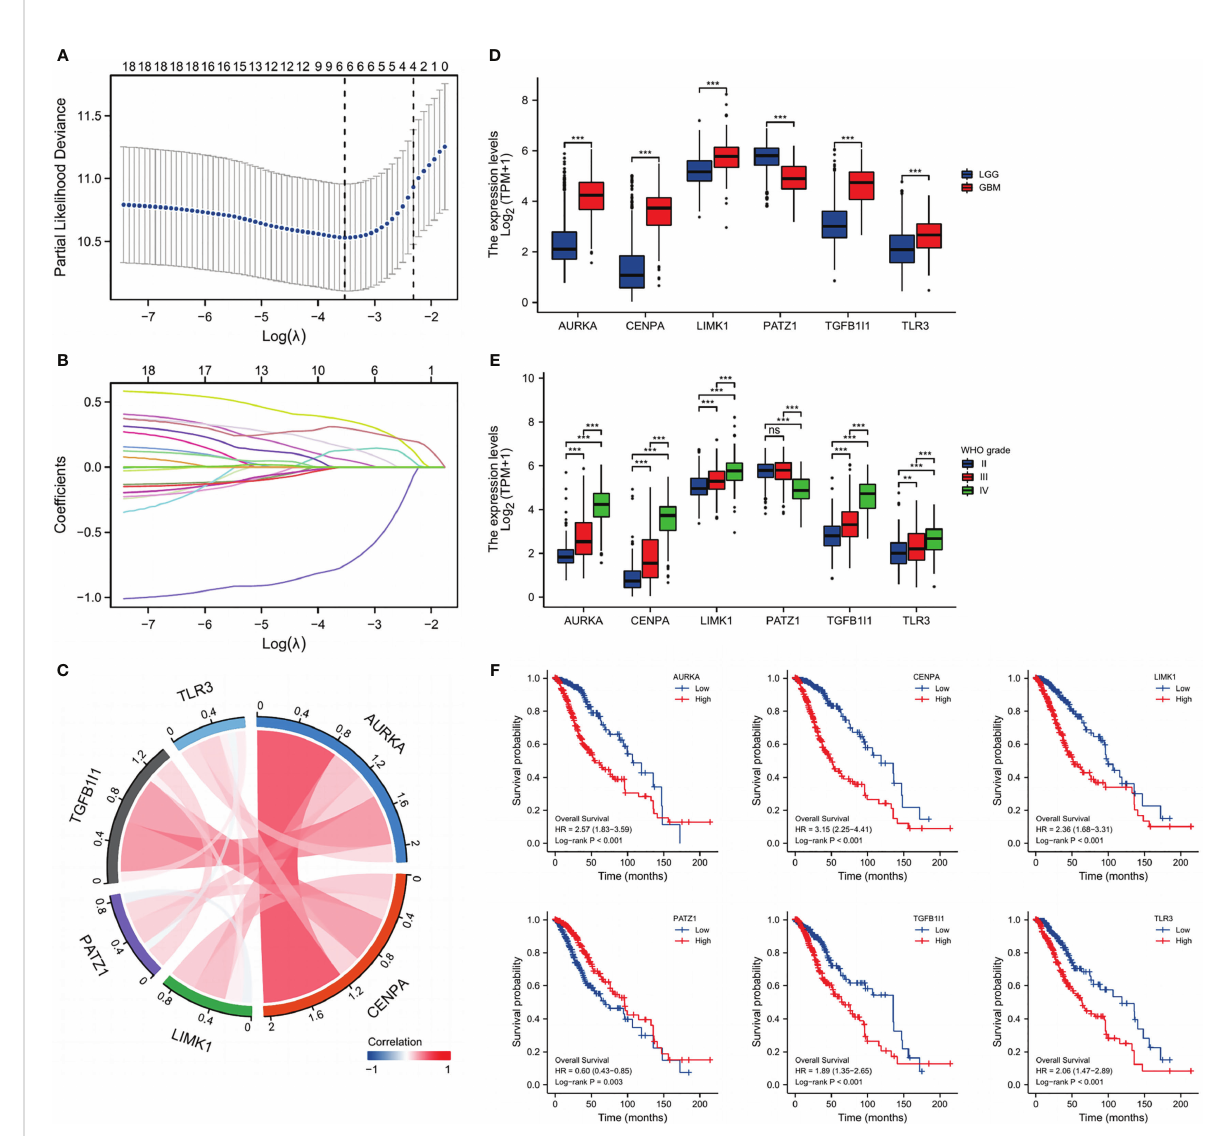
FIGURE 2 Identi fi cation of SnG-prognostic signature. (A) Cross-validation of the LASSO model ’ s parameters. (B) Coef fi cient pro fi les in LASSO regression model. (C) Correlation between the expression of the 6 SnGs. (D) Expression levels of the 6 SnGs in LGGs and GBMs. (E) Expression levels of the 6 SnGs in Grade II, III, and IV. (F) Survival analyses of the 6 SnGs by Kaplan-Meier curves and log-rank tests. **P<0.01; ***P<0.001; ns, not signi fi